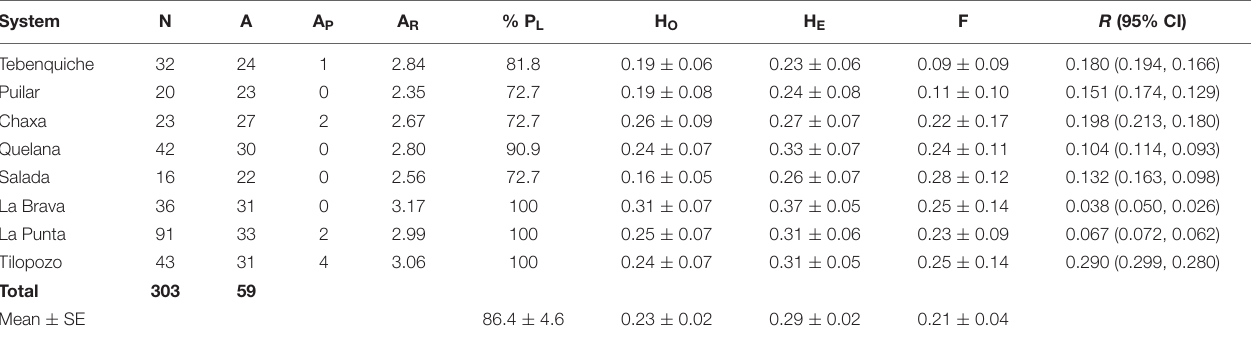
Shown are the number of samples (N), number of alleles (A), number of private alleles (A P ), average allelic richness (A R ), percentage of polymorphic loci (% P L ), observed heterozygosity (H